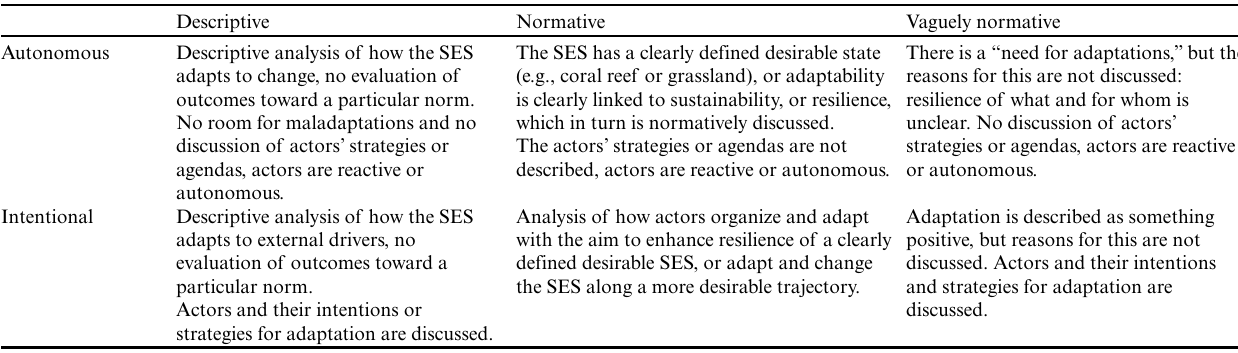
Table 3. The six possible combinations of framings. For exact coding of each framing, see Methods.